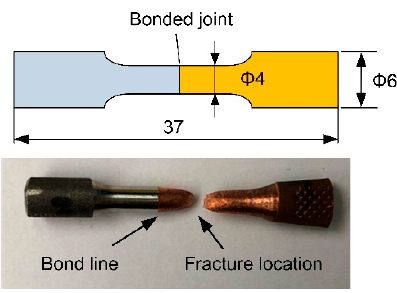
Figure 2. Dimensions (mm) and actual tensile-tested sample, which failed in copper alloy.